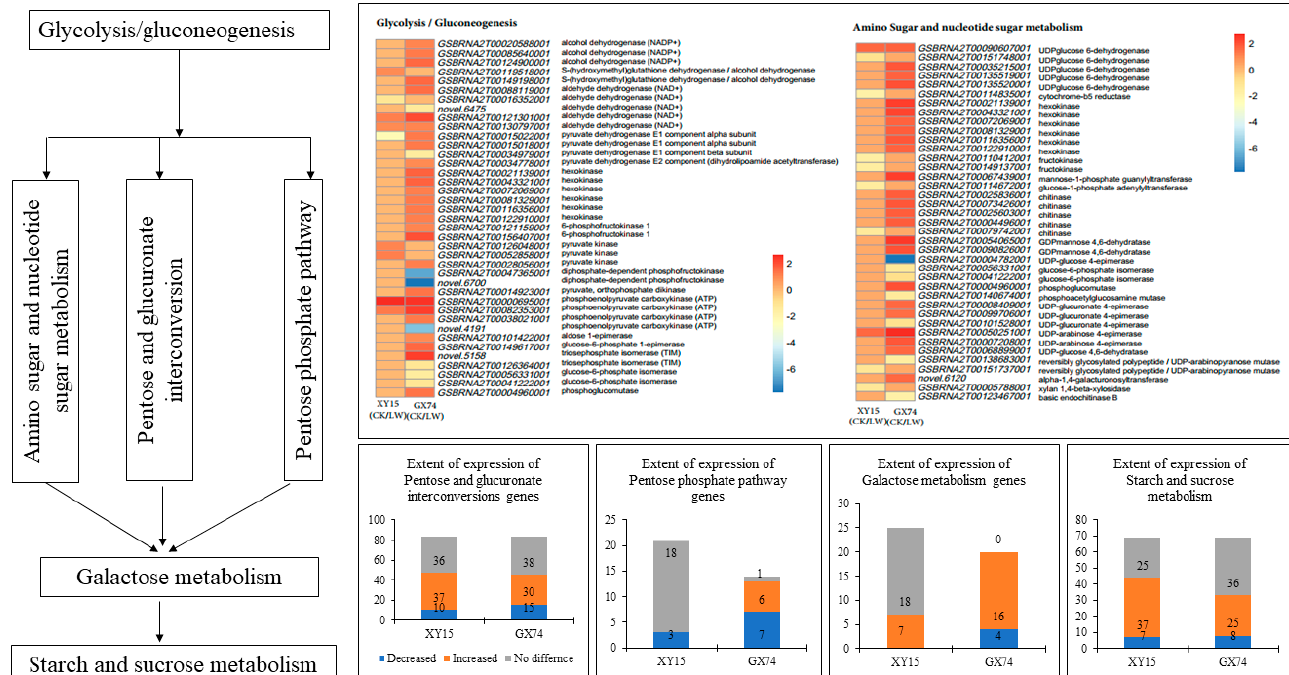
Figure 4. Sugar-related metabolism pathways in XY15 (cold-sensitive) and GX74 (cold-tolerant) rapeseed siliques in response to cold treatment. The heatmaps represent the log2 foldchange values of genes in glycolysis/gluconeogenesis, and amino sugar and nucleotide sugar metabolism. The lower four bar graphs show the other four interconnected pathways and extent of gene expression in the two genotypes before and after cold stress. The expression profiles of the genes are shown in Table S5.